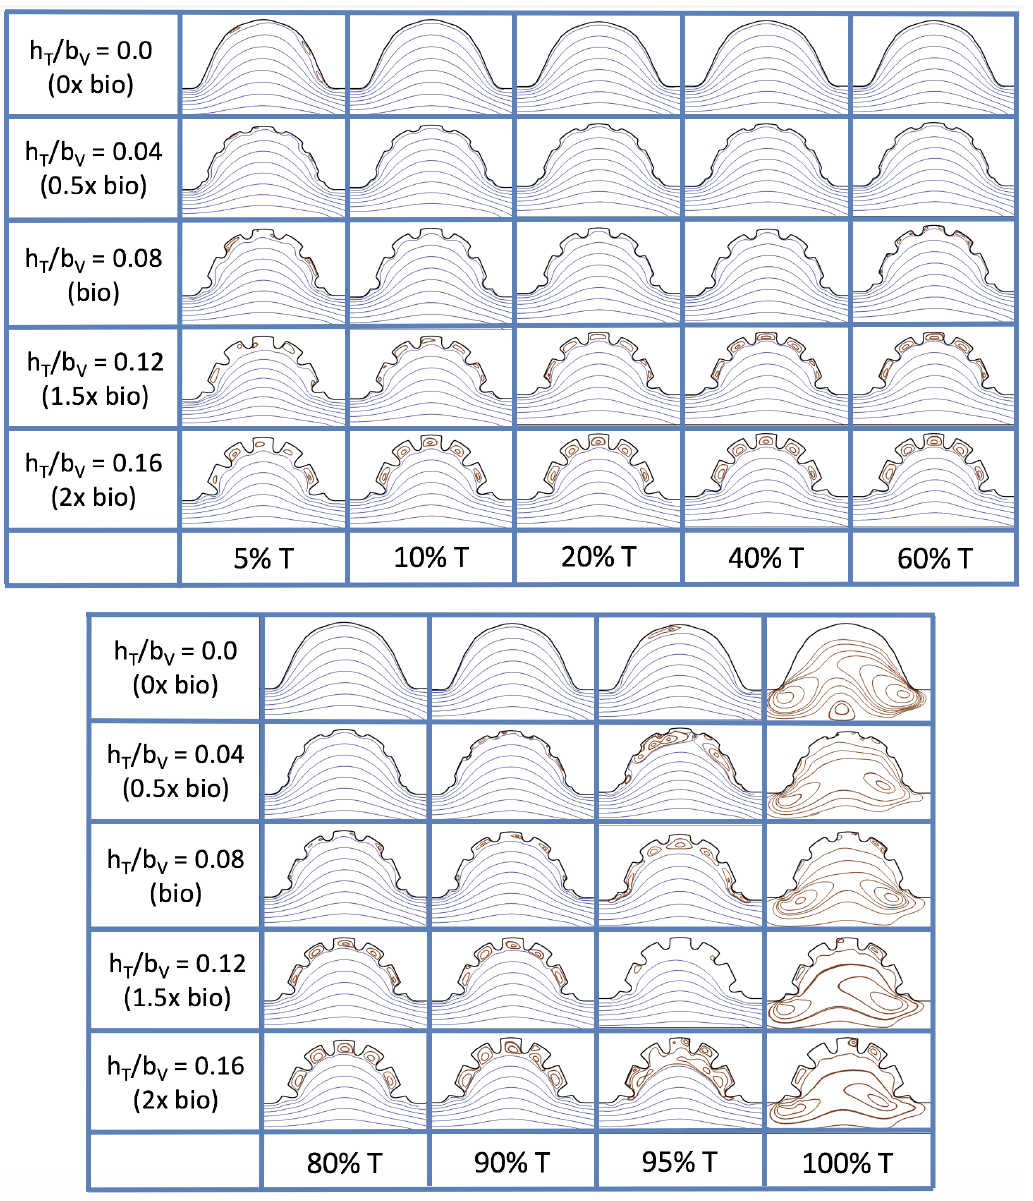
Figure 20. Streamline analysis taken at different time points within a single pulsation cycle (described by a percentage of a single pulsation period, T ) for the case of pulsatile flow into the trabeculated ventricle of a zebrafish at 4 dpf for Re = 1.0 and varying trabeculae